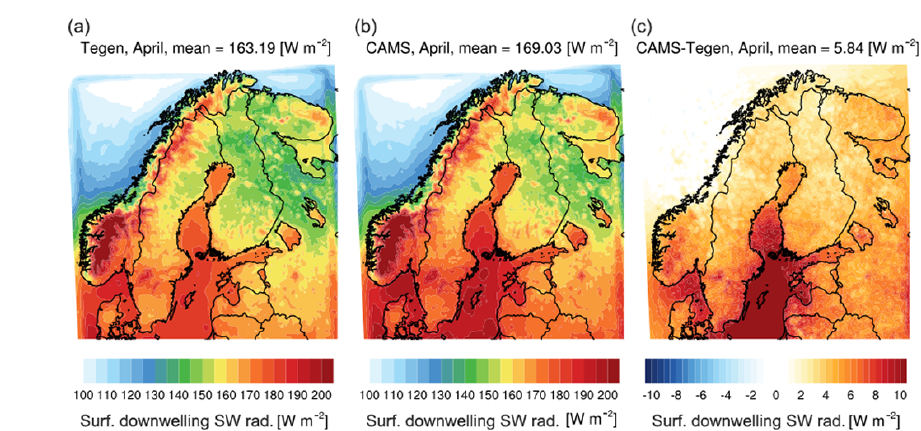
Figure 1. Monthly mean SWDS (Wm − 2 ) for 2012–2015, April: Tegen (a) , CAMSAOD (b) and the difference CAMSAOD-Tegen (c)